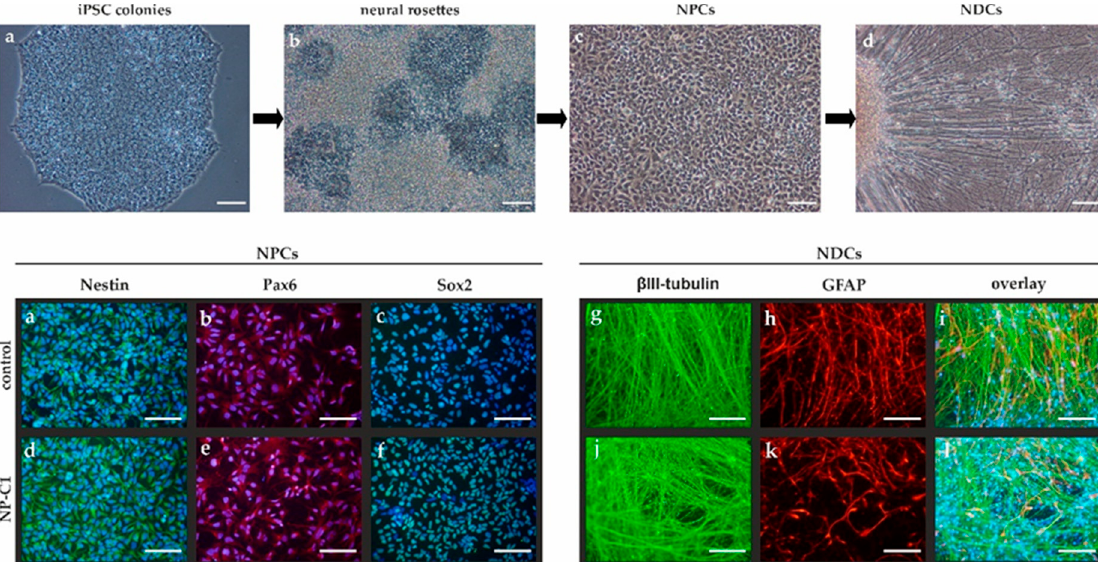
Figure 1. Neural differentiation. Upper panel : Spontaneous differentiation of iPSC colonies ( a ) was used to obtain neural rosettes ( b ) containing neural progenitor cells (NPCs, c ). NPCs were isolated and used to obtain neural differentiated cells (NDCs, d ). Lower panel : NPCs were positive for Nestin (green, a , d, DAPI in blue to counterstain for nuclei), Pax6 (red, b , e , DAPI in blue to counterstain for nuclei), and Sox2 (green, c , f , DAPI in blue to counterstain for nuclei). NPCs were terminally differentiated in NDCs positive for the neuronal marker β III-tubulin (green, g , j ) or the glial cell marker GFAP (red, h , k ). ( i , l ) overlay of ( g , h ) and ( j , k ), respectively, and DAPI in blue to counterstain for nuclei. Scale bar = 100 µm.